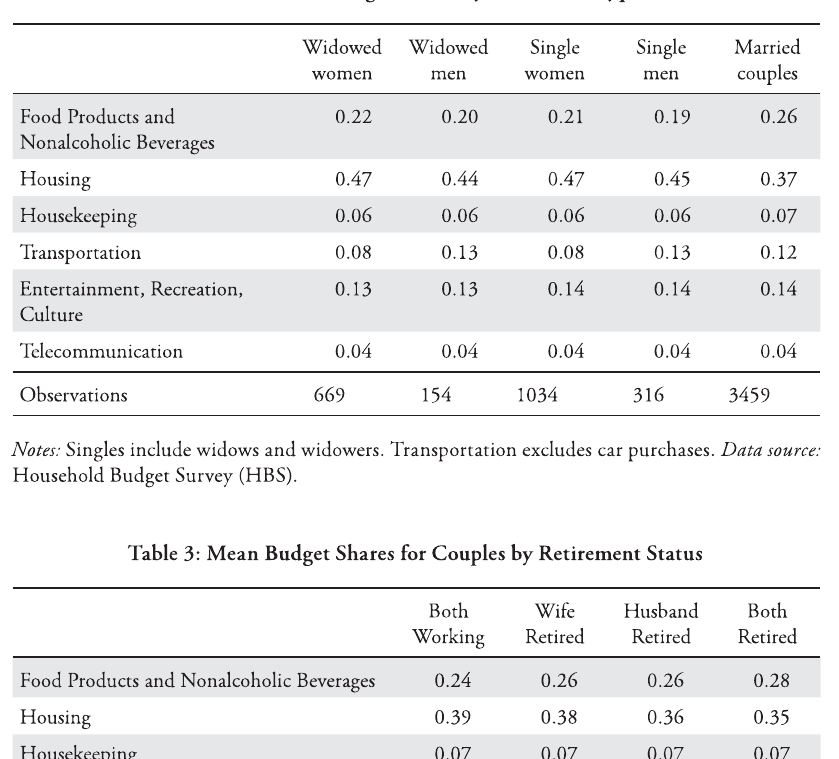
Table 2: Mean Budget Shares by Household Type